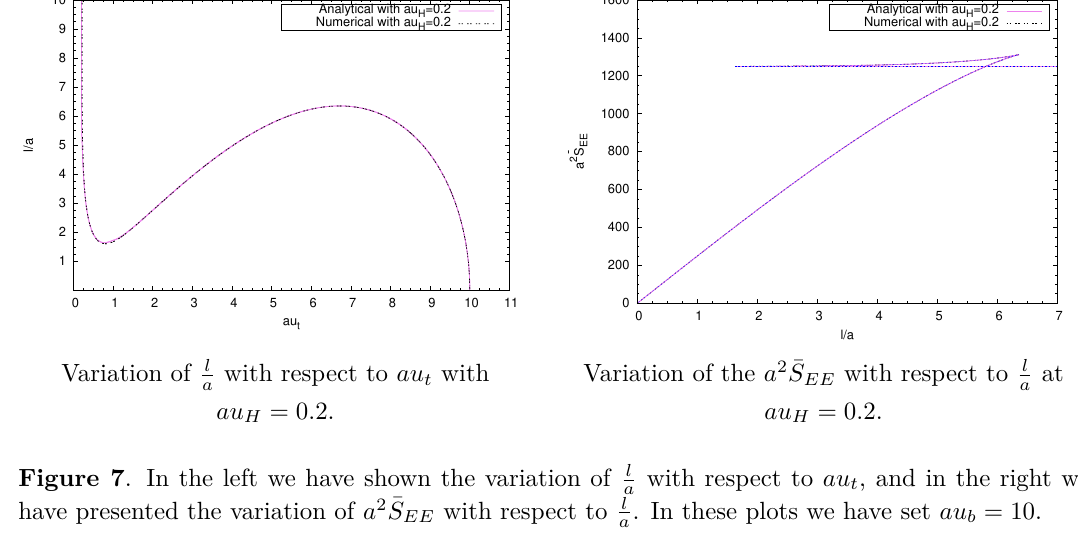
with respect to au t , and in the right we a . In these plots we have set au b = 10 a